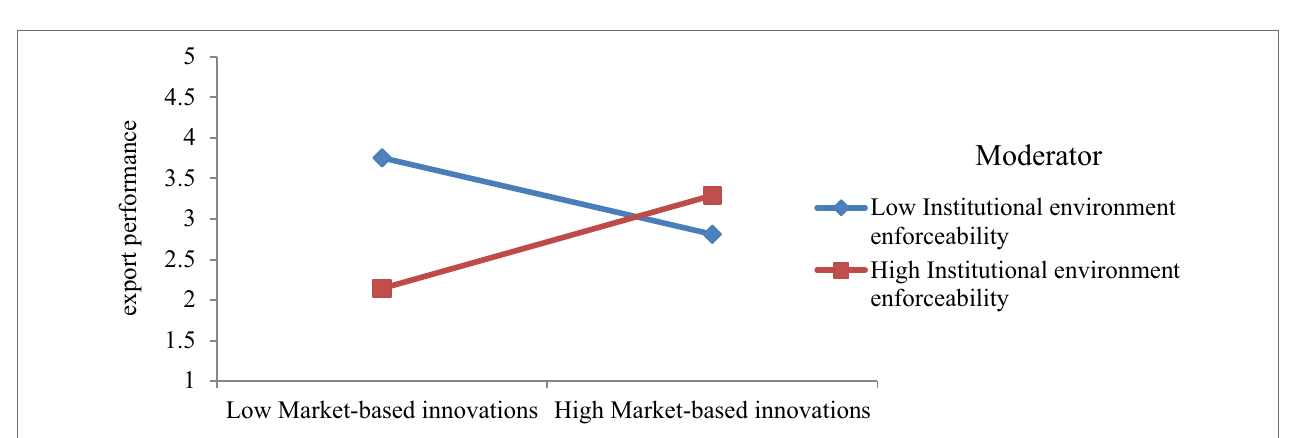
FIGURE 10 | Interaction of model